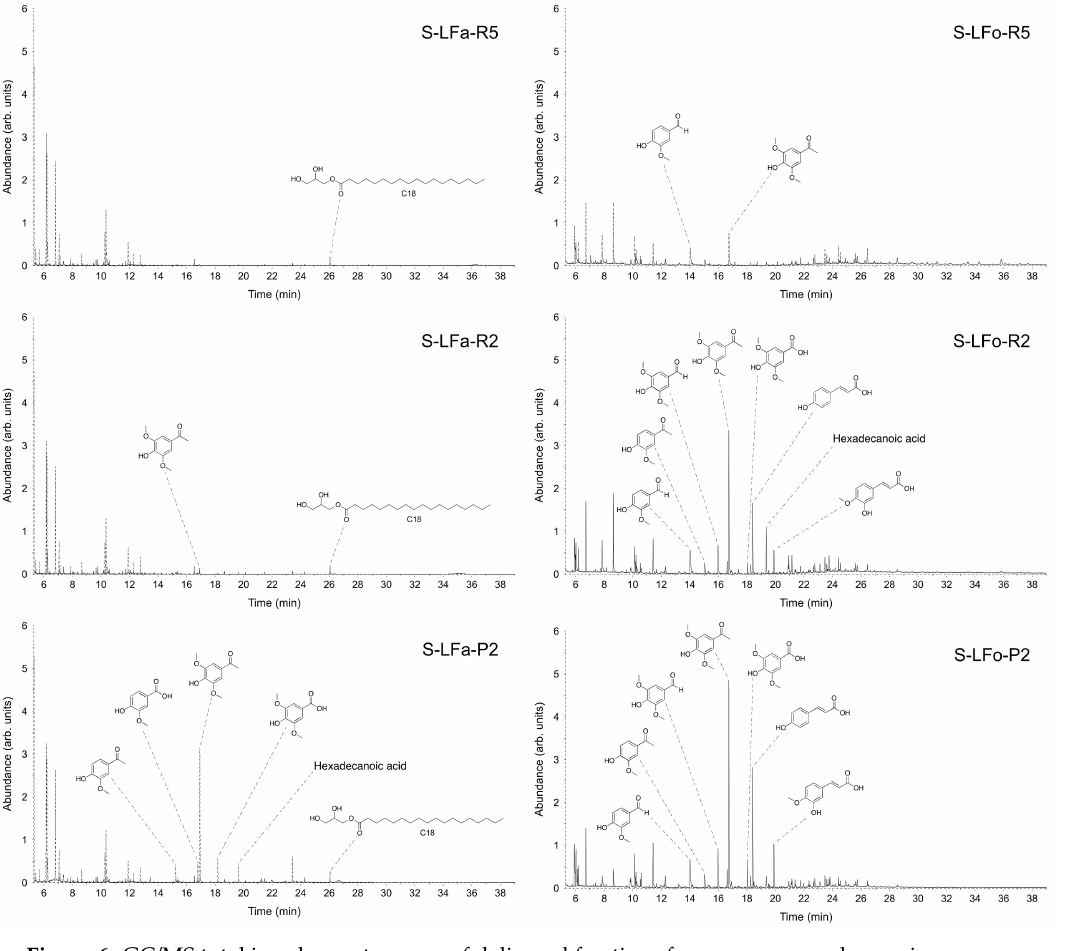
Figure 6. GC / MS total ion chromatograms of delivered fractions from aqueous and organic processes using S-LFa / o-0. Selected component identification by MS library matching is reported for each